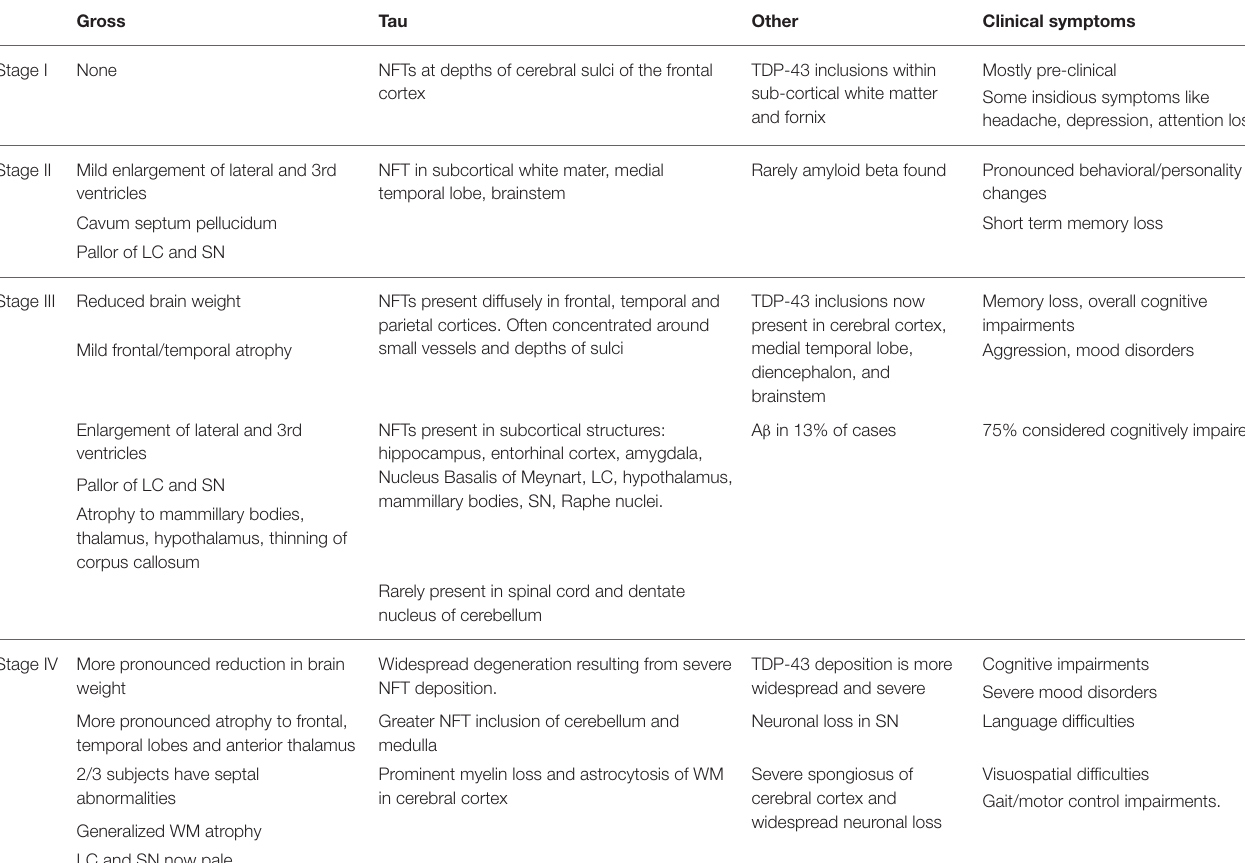
TABLE 1 | Stages of CTE proposed by McKee et al.